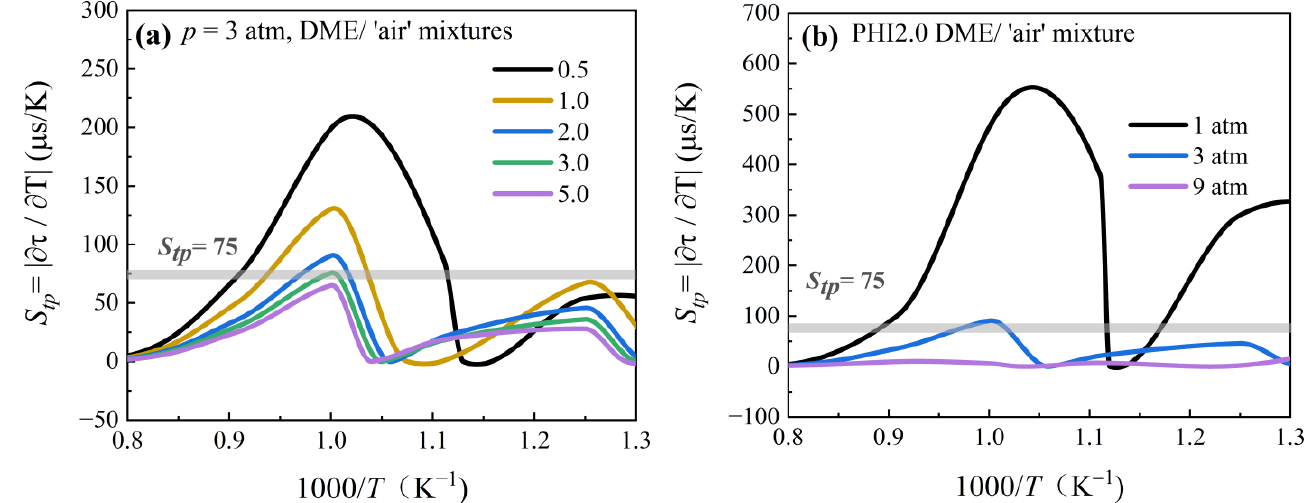
Figure 6. Temperature perturbation sensitivity coefficient S tp of DME/‘air’ mixtures with equivalence ratios ranging from 0.5 to 5.0 and pressures of 1 – 9 atm. ( a ) Equivalence ratio dependence. ( b ) Pressure dependence.